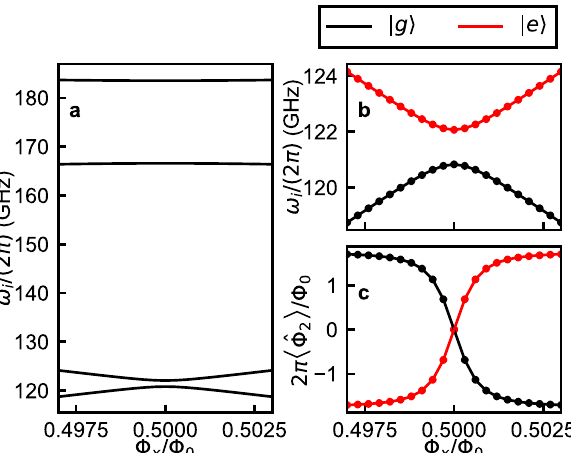
Figure 3. ( a ) Numerically calculated energy levels of ˆ H 2 as functions of (cid:31) x . ( b ) The lowest two energy levels of